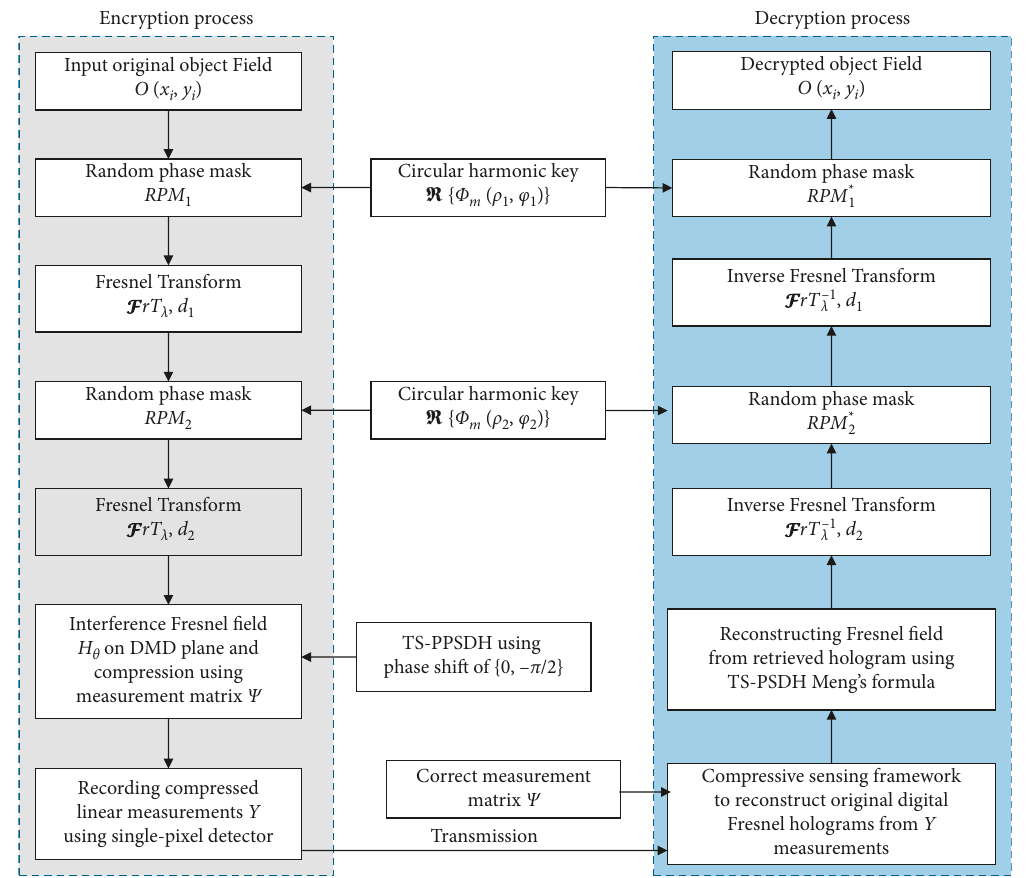
Figure 3: Flowchart of compressive digital holographic encryption and decryption